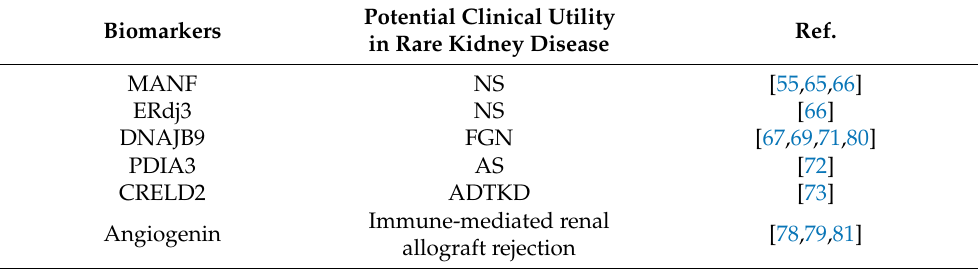
Table 1. ER-associated biomarkers in rare kidney